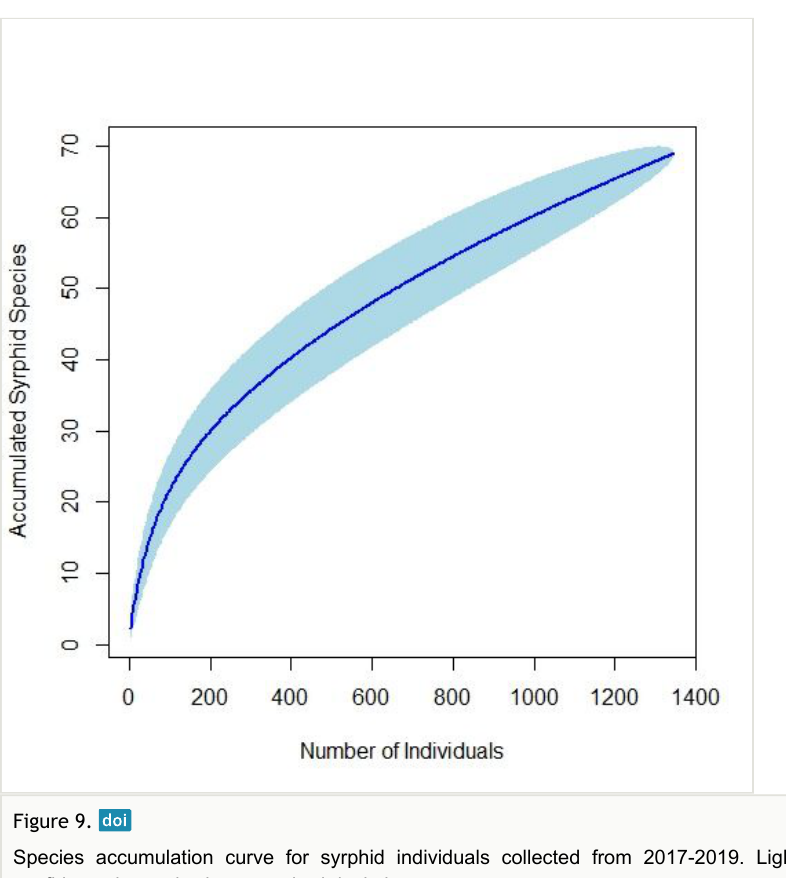
Species accumulation curve for syrphid individuals collected from 2017-2019. Light blue confidence intervals show standard